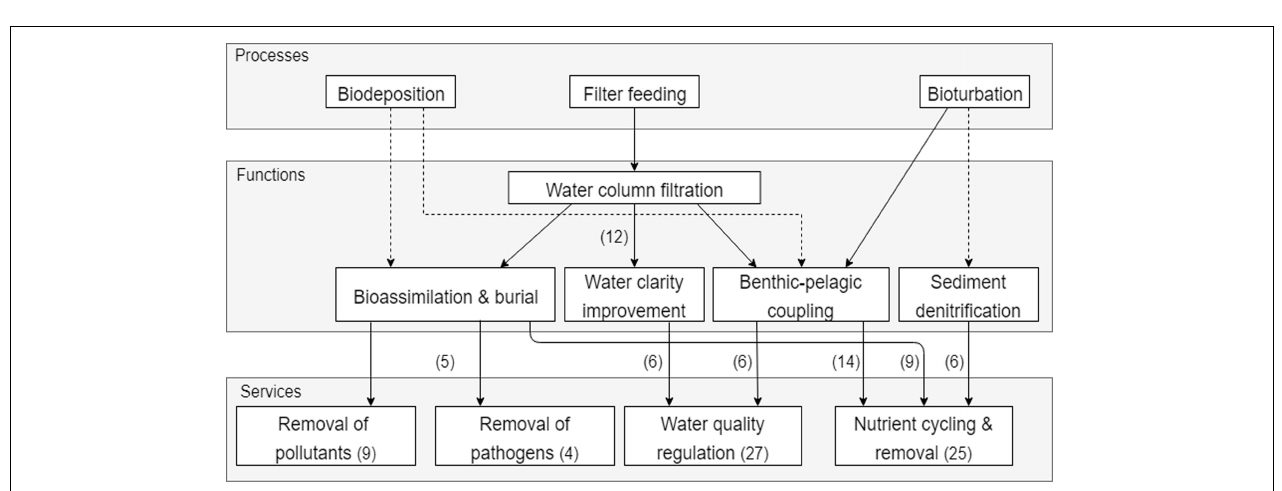
FIGURE 3 | Simplified cascade showing the links between processes, functions, and services in the Marine resources bundle. The number of papers discussing a service is indicated in brackets within the service box, while the number of times links between processes and functions were discussed is indicated in brackets next to the arrows.